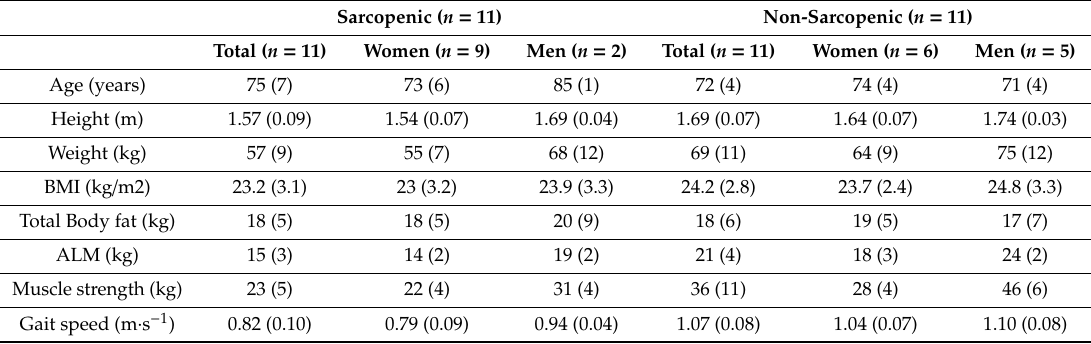
Table 3. Descriptive statistics of the study population represented as mean ( ± standard deviation).